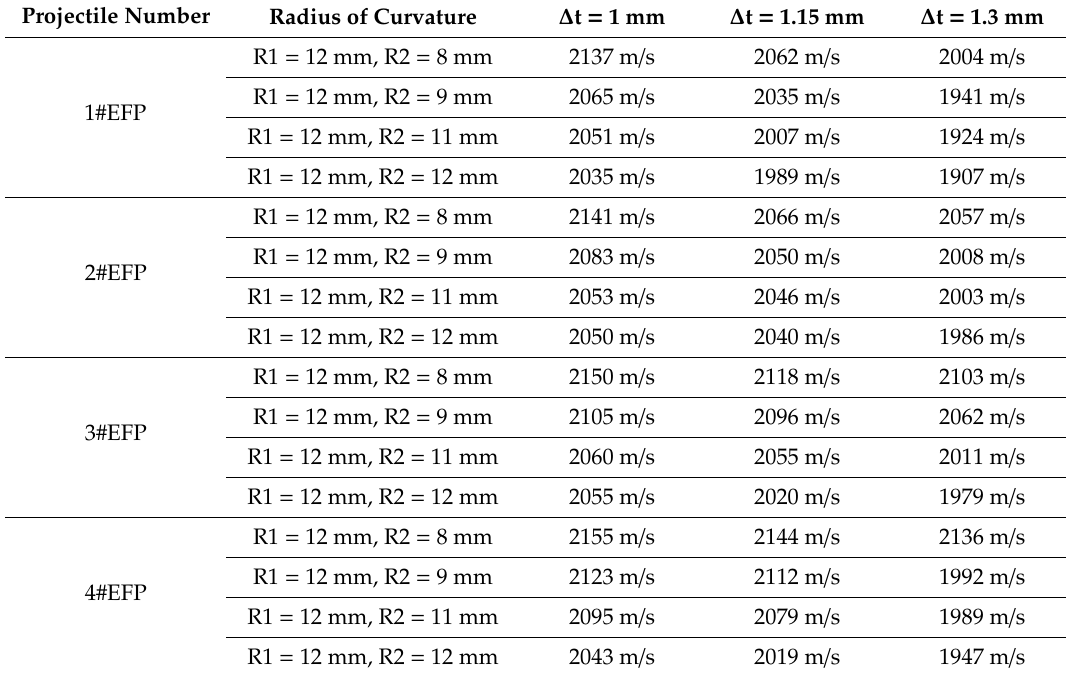
Table 8. 1#EFP-4#EFP formed velocity for R1 = 12 mm.